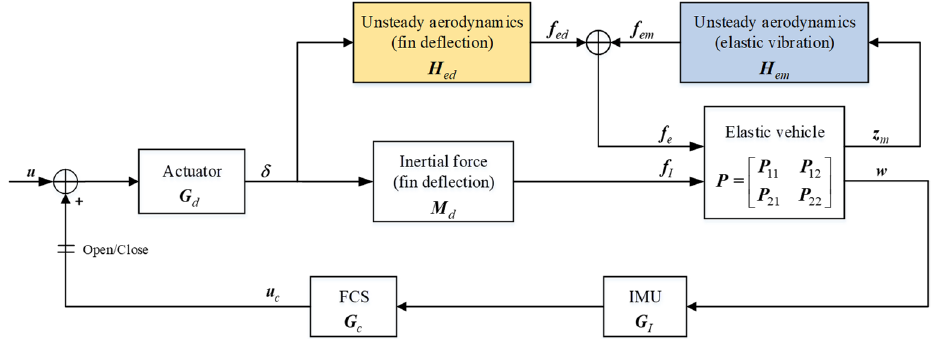
Figure 3. Block diagram of the improved ASE system.